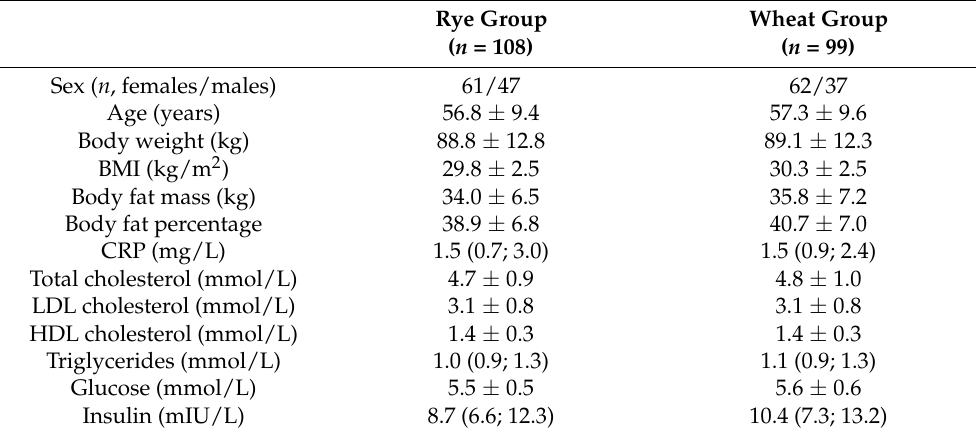
Table 1. Baseline